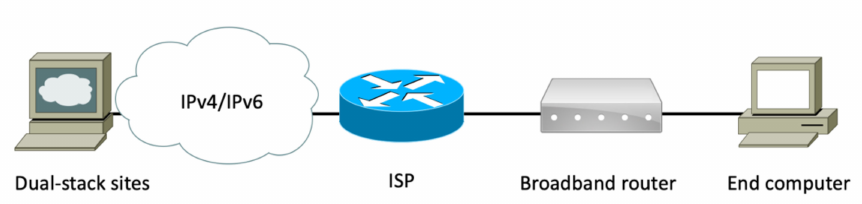
Figure 1. Network testing